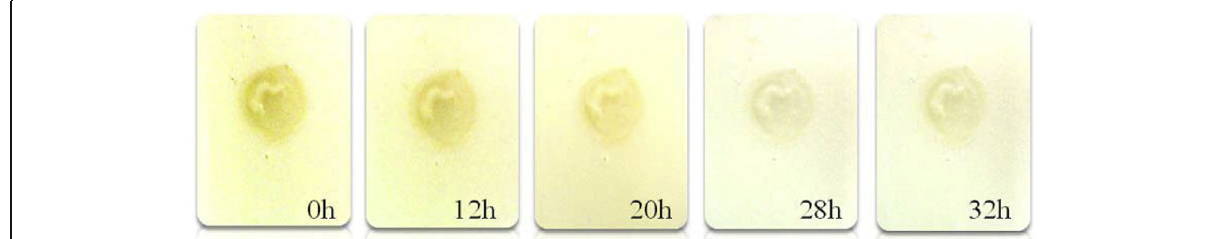
Fig. 5 Discoloration of coffee stain on casein-based TiO 2 nanocomposite treated fabric under UV irradiation [29]. Copyright 2016,